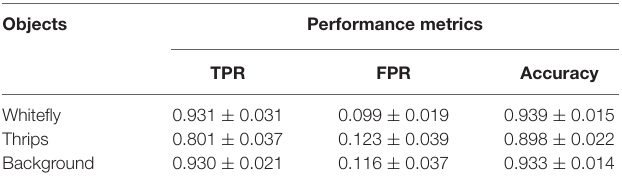
TABLE 1 | Detection performance for small-size pests (whitefly and thrips) by the SVM classifier using field sticky trap images ( n = 18, mean ± SD ). Objects